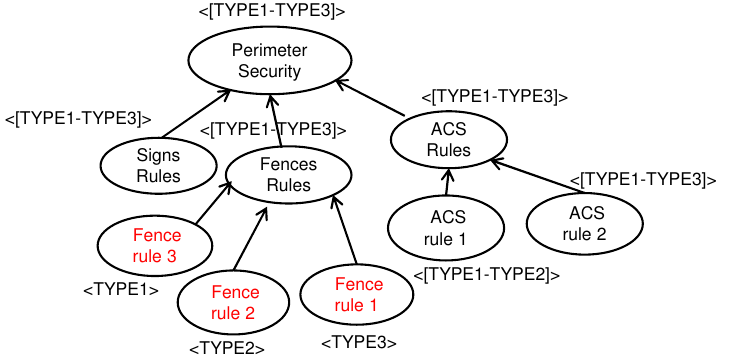
Figure 3. A union model for the model family in Figure